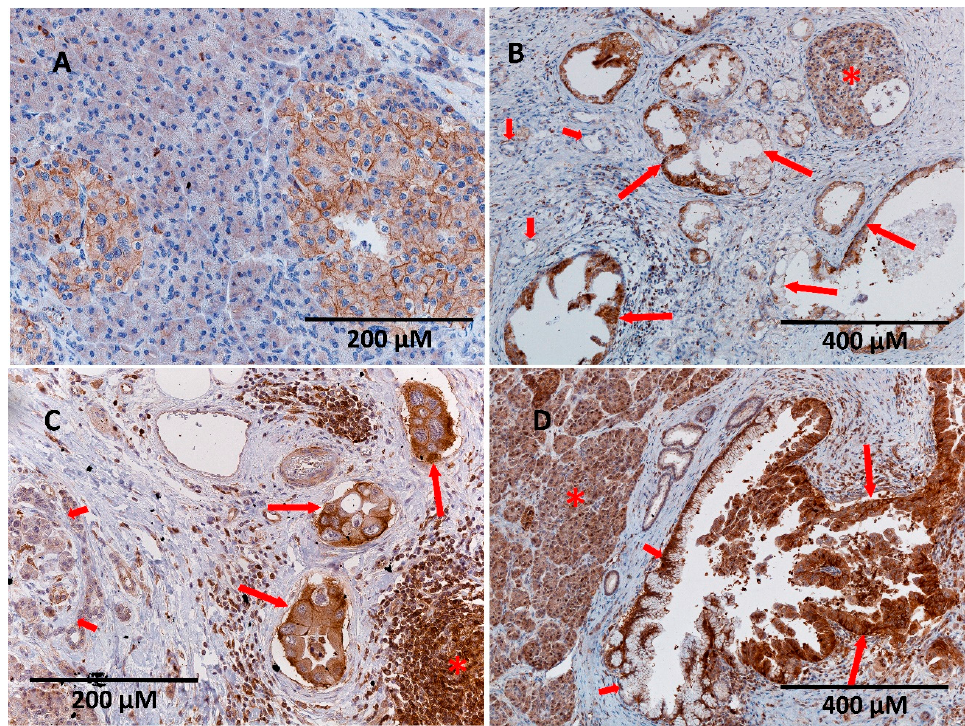
Figure 3. Variability of expression of ENT1 transporter in normal pancreas and pancreatic ductal adenocarcinoma (PDAC). ( A ) Membranous expression is seen in cells of normal Langerhans islets, whereas pancreatic acini are completely negative. ( B ) In some cases, heterogeneous positivity of neoplastic cells of PDAC could be observed (long arrows). Note that the non-neoplastic ducts are negative (short arrows). Membranous positivity in the cells of normal Langerhans islets served as an internal positive control (asterisk). ( C ) PDAC cells with strong membranous and cytoplasmic staining for ENT1 (long arrows). Lymphoid elements show the same level of positivity (asterisk), whereas non-neoplastic exocrine pancreas is virtually negative (short arrows). ( D ) Strong cytoplasmic staining in both the acini of normal pancreas (asterisk) and neoplastic cells lining the dilated duct (long arrows), whereas non-neoplastic ductal cells show only weak membranous, predominantly basal, positivity (short arrows). Original magnification was 200× ( A , C ) and 100× ( B , D ).